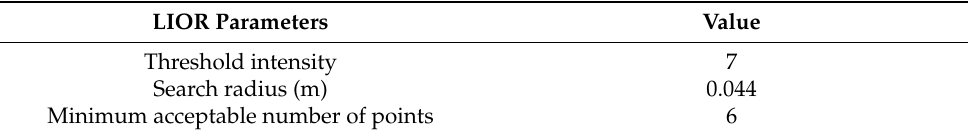
Figure 4. An illustration of how the tuning of LIOR and LIDROR were performed. Table 2. LIOR final